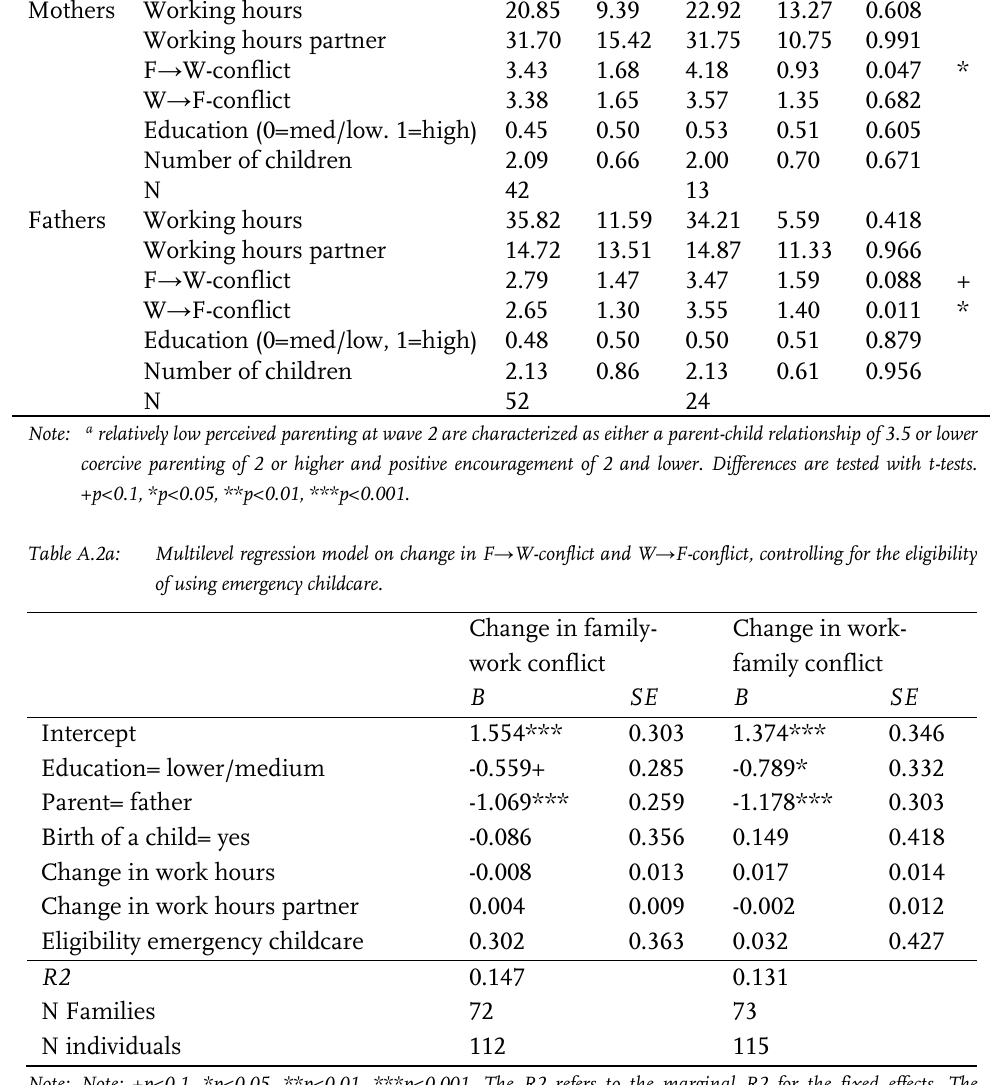
Relatively low perceived parenting at wave 2 a